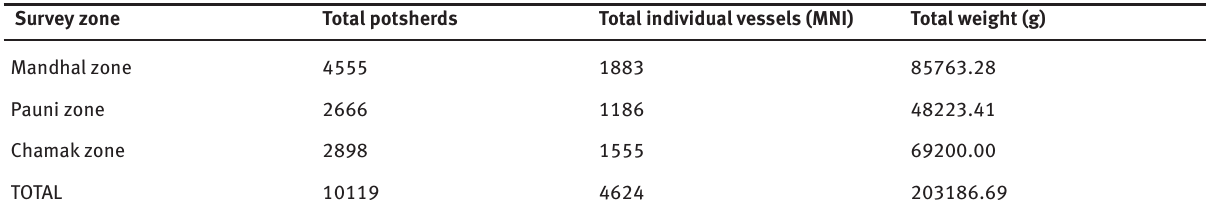
Table 1: Total counts and weights of potsherds collected during surface surveys in each survey zone. Survey